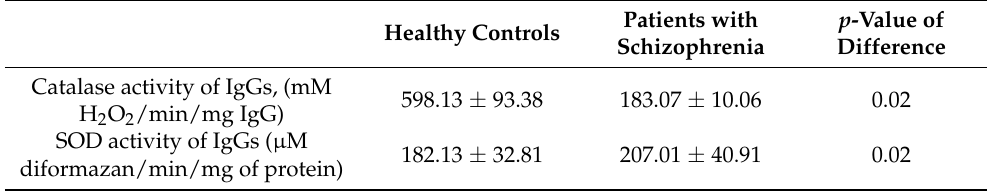
Table 2. Catalase and SOD activities of IgGs from patients with acute schizophrenia and healthy controls.